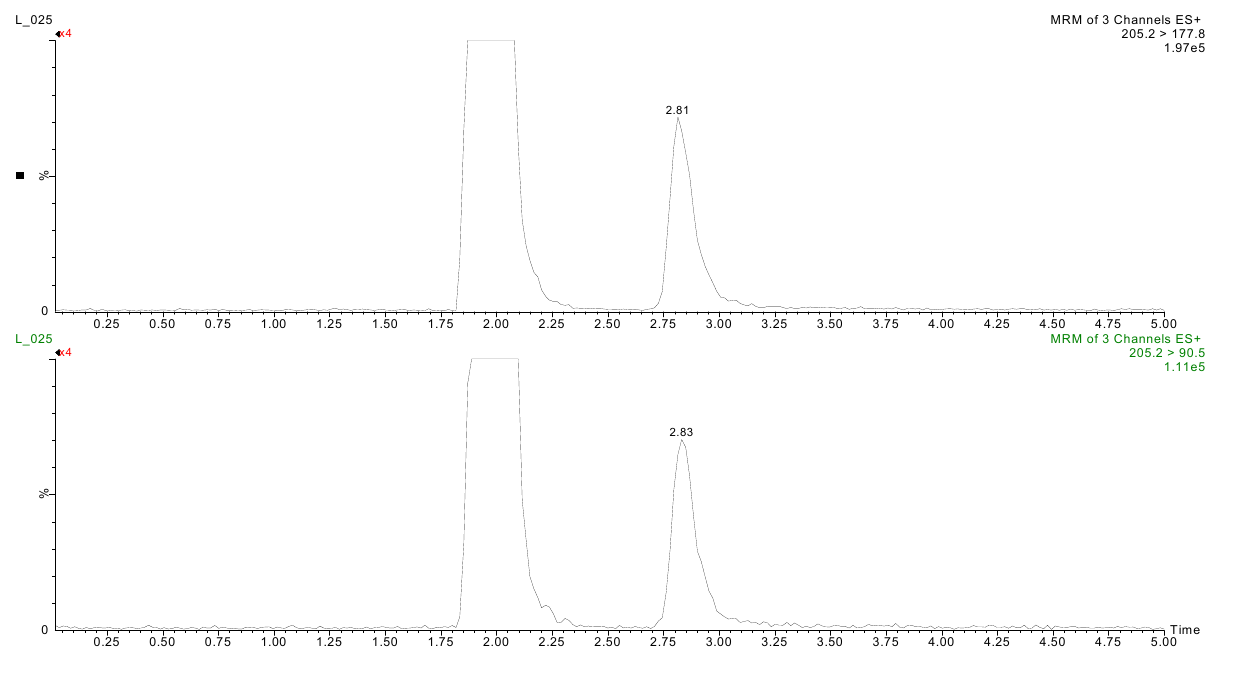
Figure A5. Chromatogram of the liver sample treated at 10 ppb.